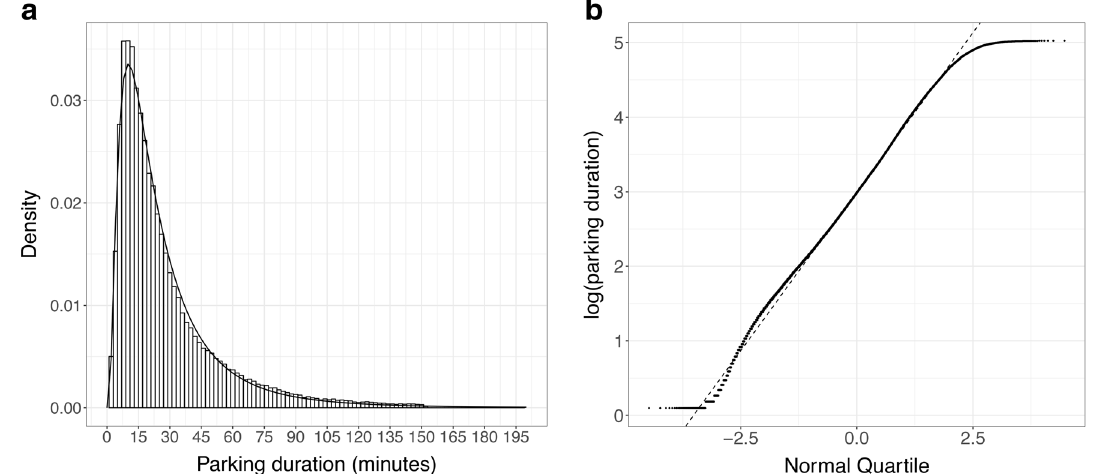
Fig. 5 a Histogram of parking duration with a lognormal ( μ = 3.02, σ = 0.89) superimposed. b Normal Q-Q plot of the logarithm of parking